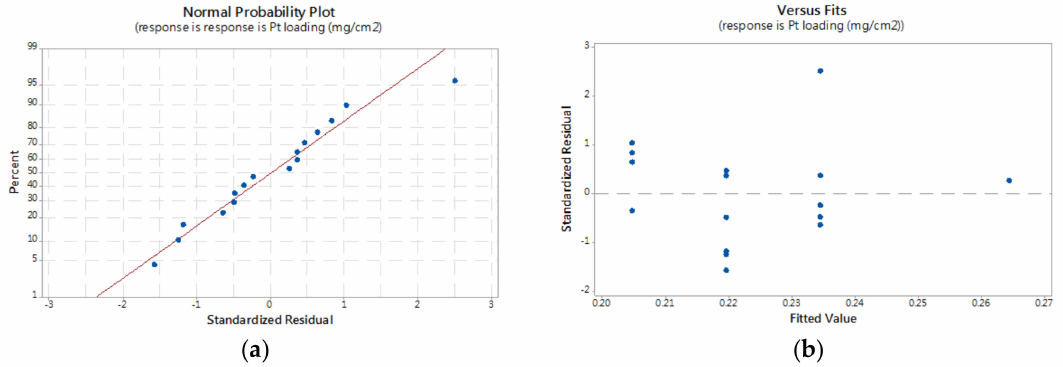
Figure 3. Residual plots in the regression analysis: ( a ) normal probability plot and ( b ) residuals versus fit of